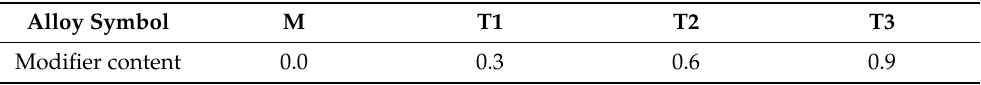
Table 1. Alloy symbols and the corresponding modifier contents of four specimens (wt.%).